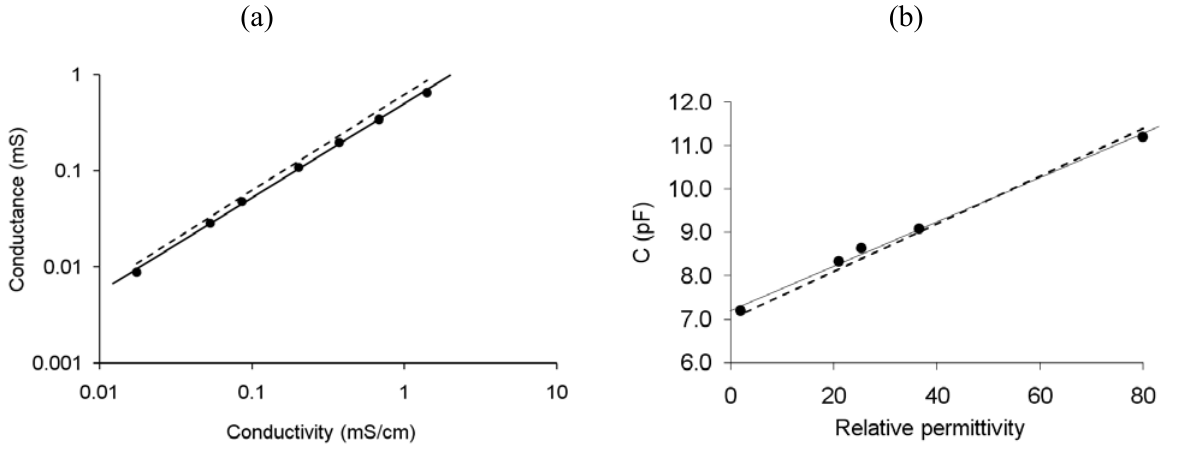
Figure 5. Characterization results of the interdigitated electrodes: (a) Measured conductance for different solution conductivities. (b) Measured capacitance for different solution permittivities. Dashed lines show the response estimated from FEA